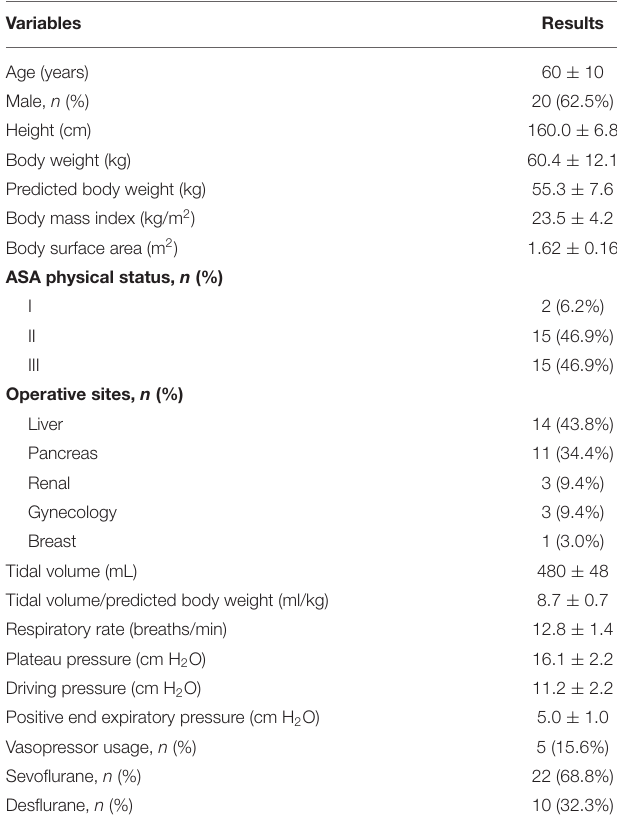
TABLE 1 | Patient baseline characteristics ( n = 32).